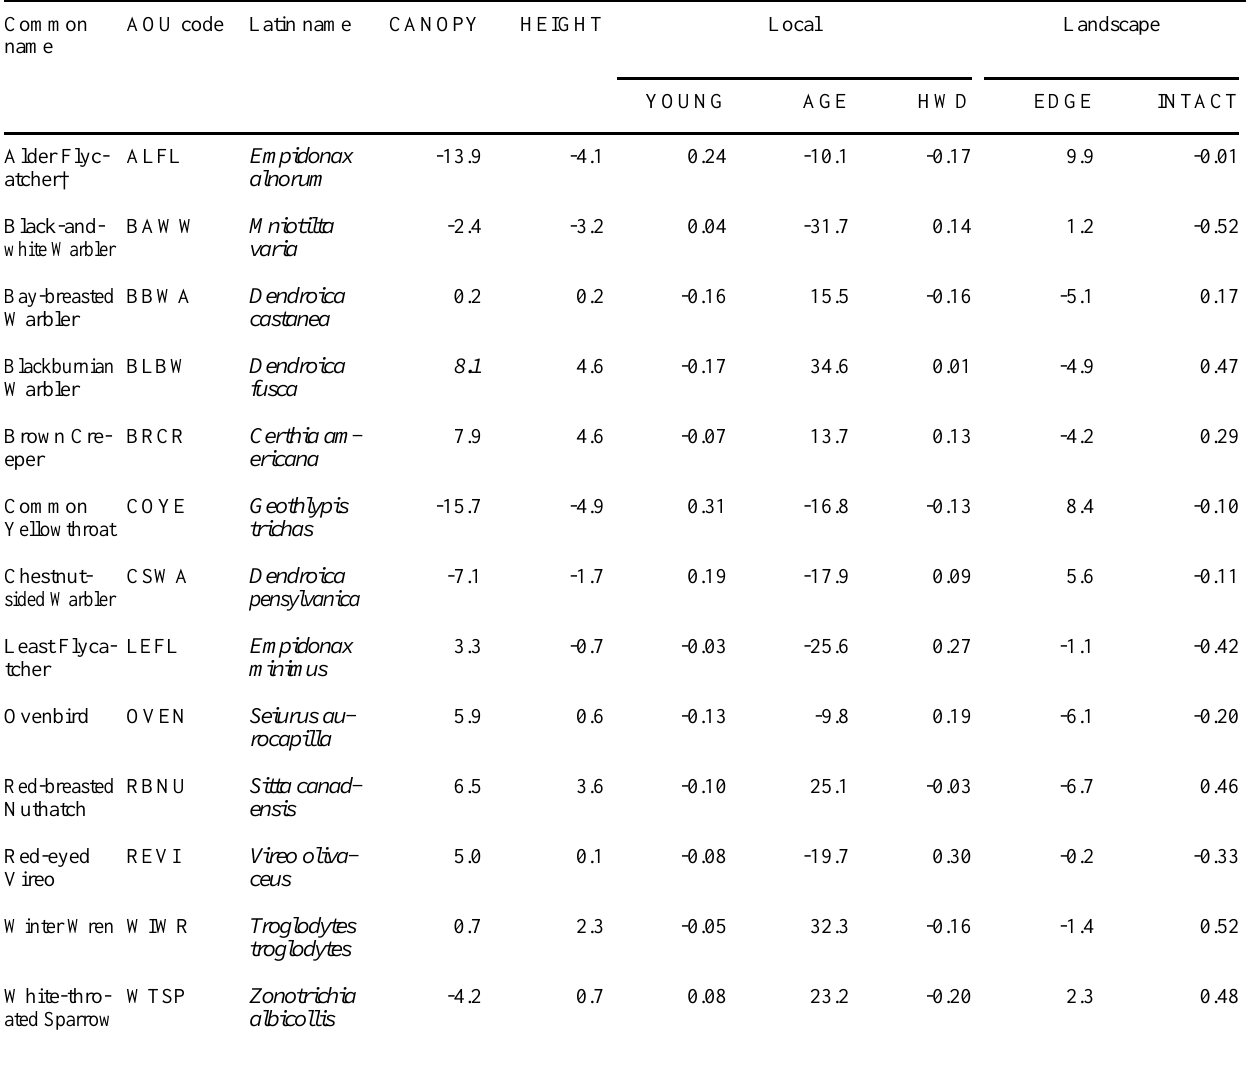
Table 3. Difference in habitat variable averages for high vs. low probability of habitat occupancy, when the habitat models are applied to the current forest